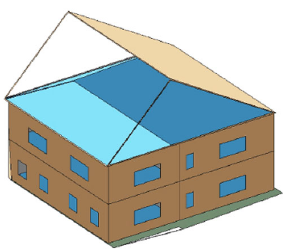
Figure 13. Flying roof shading effect on the summer solstice at noon.